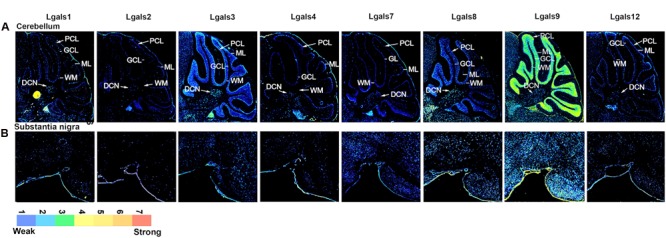
Galectins expression in mouse Cerebellum and Substantia nigra (A) Expression profile of galectins in cerebellum. DCN, deep cerebellar nuclei; WM, white matter; ML, molecular layer; GCL, granular cell layer; PCL, Purkinje cell layer. (B) Expression profile of galectins in substantia nigra.